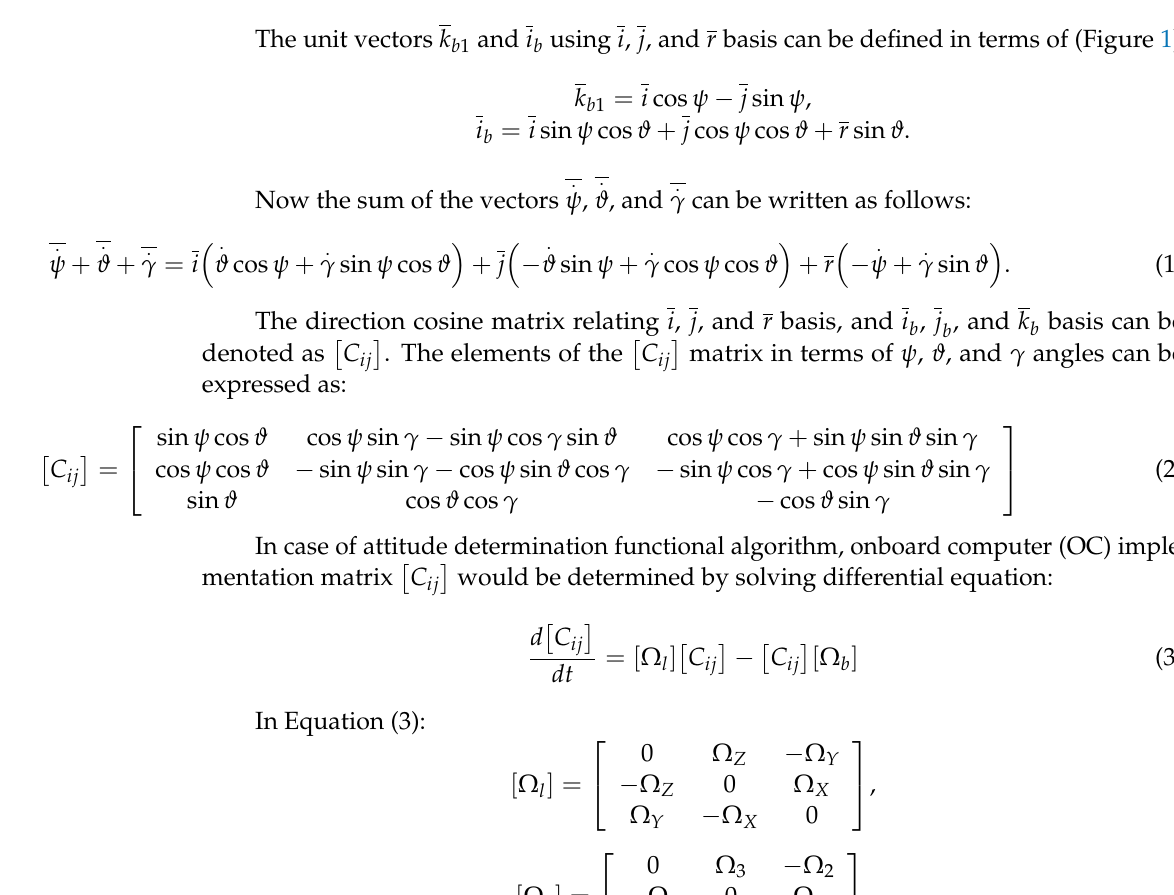
Figure 1. Frames and unit vectors.